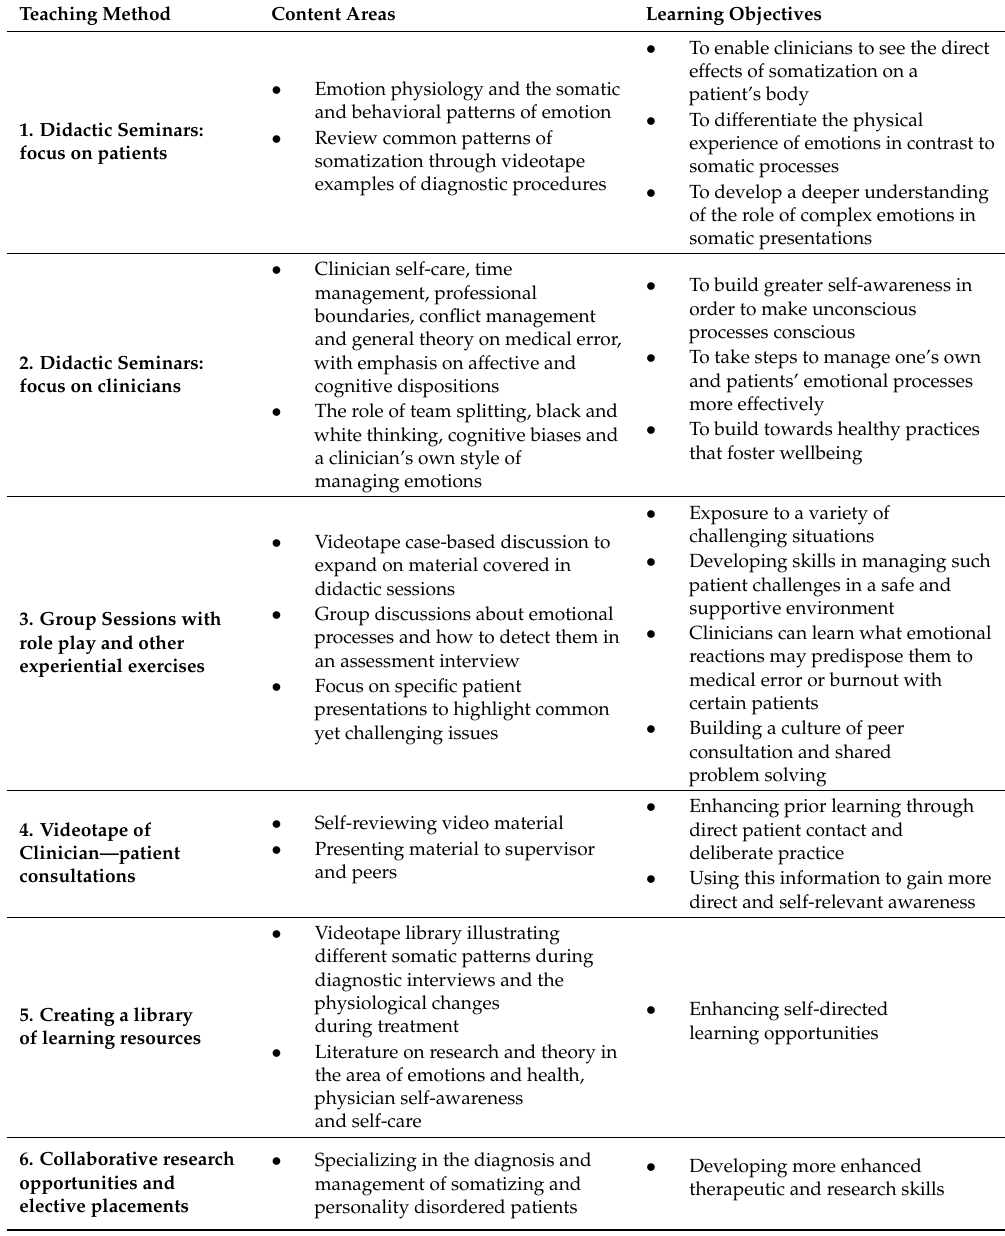
Table 5. Outline of a Curriculum for Emotion-linked